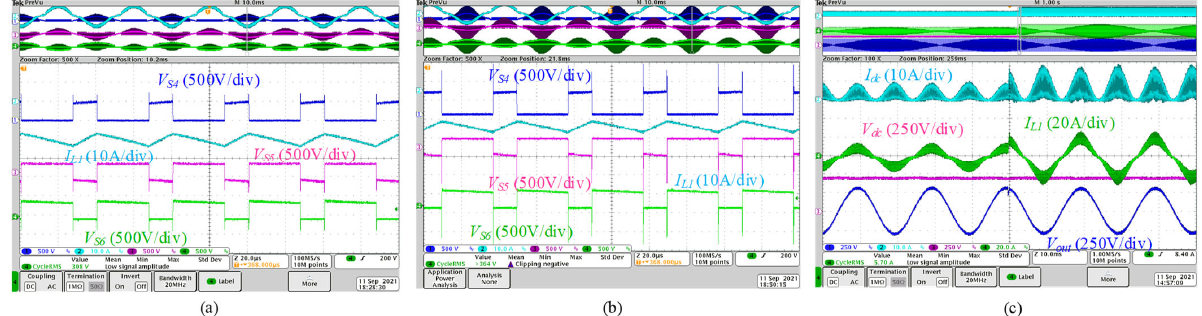
Figure 11. Experimental results of voltage stresses of the switches: voltage stress of switch S 4 , FI current, voltage stress of switch S 5 , and voltage stress of switch S 6 from top to bottom, respectively; ( a ) with precise adjustment of dead time between the switches, ( b ) without precise adjustment of dead time between the switches, and ( c ) the input current, FI current, input voltage, and output voltage at the step change of output power from 1 kW to 2 kW and with input voltage of 400 V.